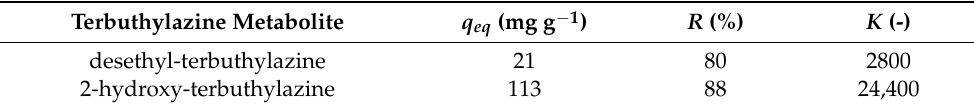
Table 3. Sorption capacity ( q eq ), retention rate ( R ) and distribution coefficient ( K ) for adsorbed terbuthylazine